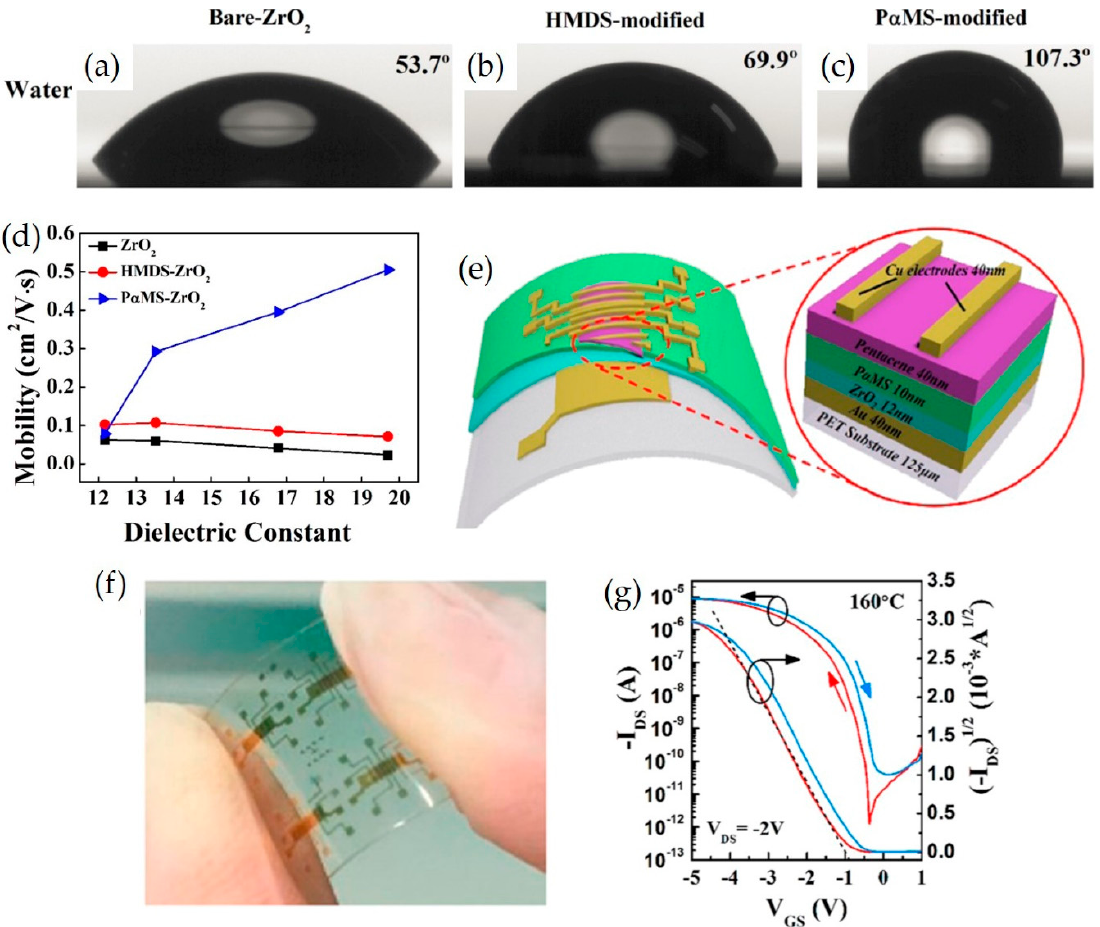
Figure 11. Water contact angles of ( a ) bare-ZrO 2 surface, ( b ) HMDS modified surface, ( c ) P α MS modified surface. ( d ) Field e ff ect hole mobility as a function of ZrO 2 dielectric constant for OFETs with di ff erent surface modifications. The mobility was calculated with V G = − 5 V and capacity density under f = 1 kHz. ( e ) Schematic diagram of the flexible OTFT fabricated on PET substrate and ( f ) the digital photograph of the flexible OTFTs. ( g ) I DS –V GS transfer curves of a ZrO 2 -OFET constructed on PET flexible substrate. The channel width and length of the transistor are 750 µ m and 50 µ m, respectively. Reproduced with permission from [138], Copyright 2016 American Chemical Society.